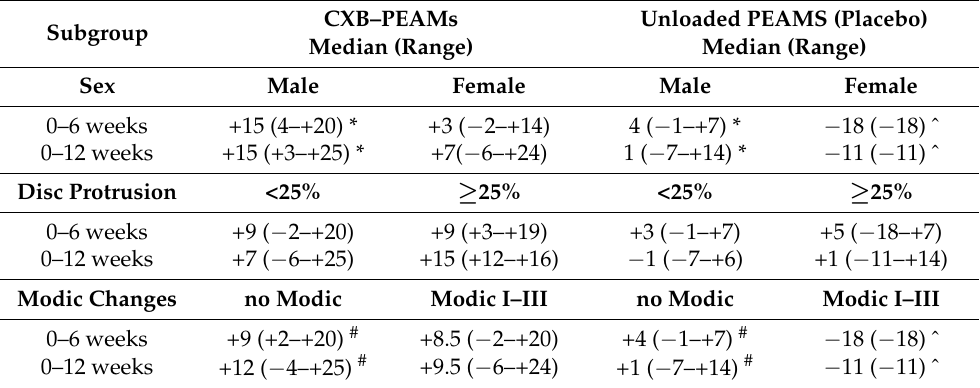
Table 4. Subgroup analyses of primary outcome (change in questionnaire sumscore) of 30 dogs suffering from degenerative lumbosacral stenosis treated with intradiscal injection of celecoxib- polyesteramide microspheres (CXB-PEAMs) or unloaded PEAMs (placebo).